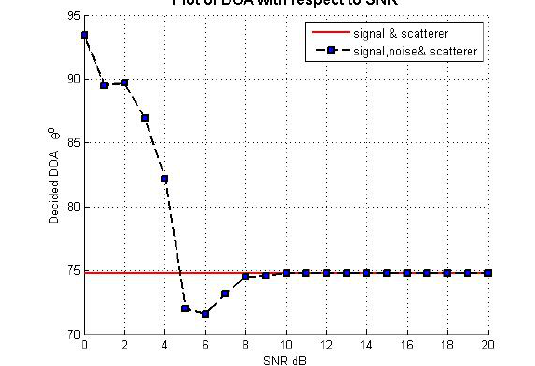
Figure 6: Plot of DOA with respect to SNR for case 1